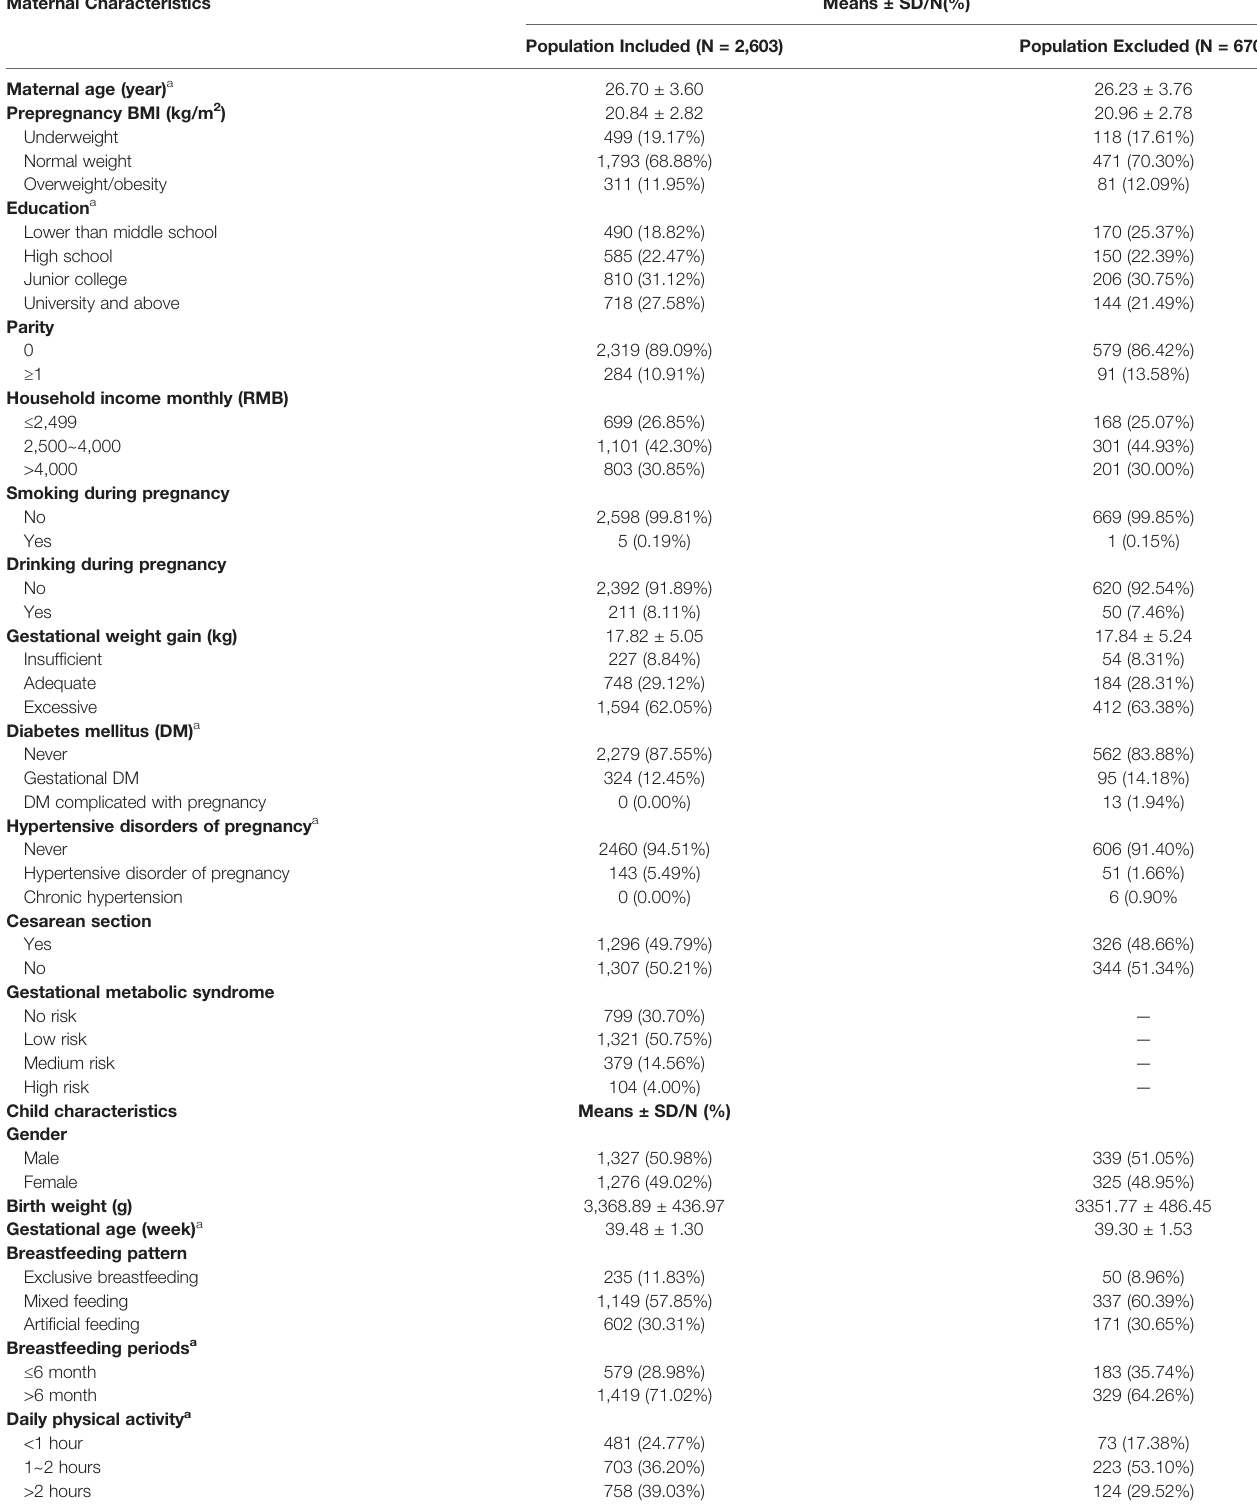
TABLE 1 | Demographic characteristics of the population included and excluded in the present study. Maternal